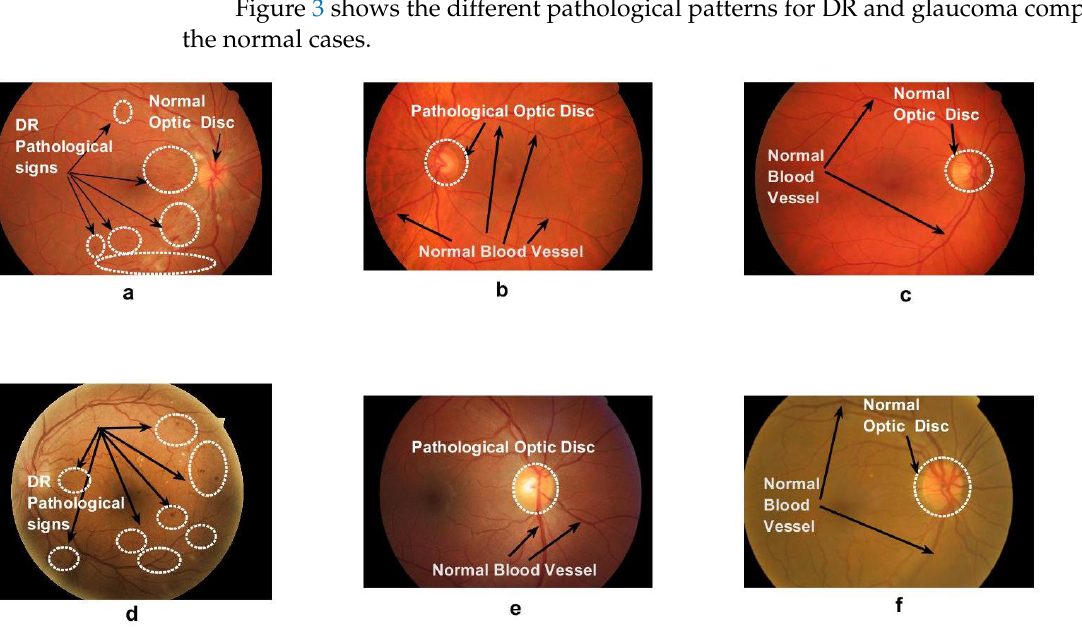
Figure 3. Sample images from the two datasets: ( a ) DR image from HRF dataset; ( b ) glaucoma image from HRF dataset; ( c ) normal (healthy) image form HRF dataset; ( d ) DR image from Dataset_2; ( e ) glaucoma image from Dataset_2; ( f ) normal image from